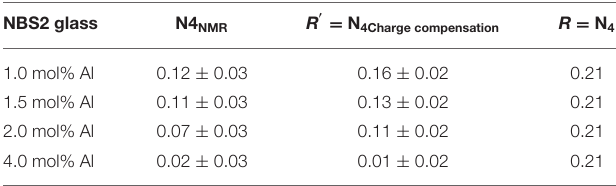
TABLE 2 | The fraction of tetragonal boron: N4 NMR are the results from NMR deconvolution. NBS2 glass N4 NMR